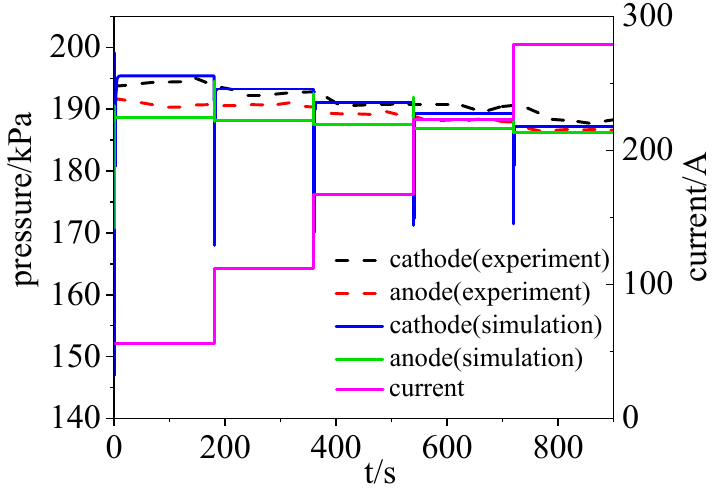
Figure 5. Comparison of experimental and simulation results for pressure.